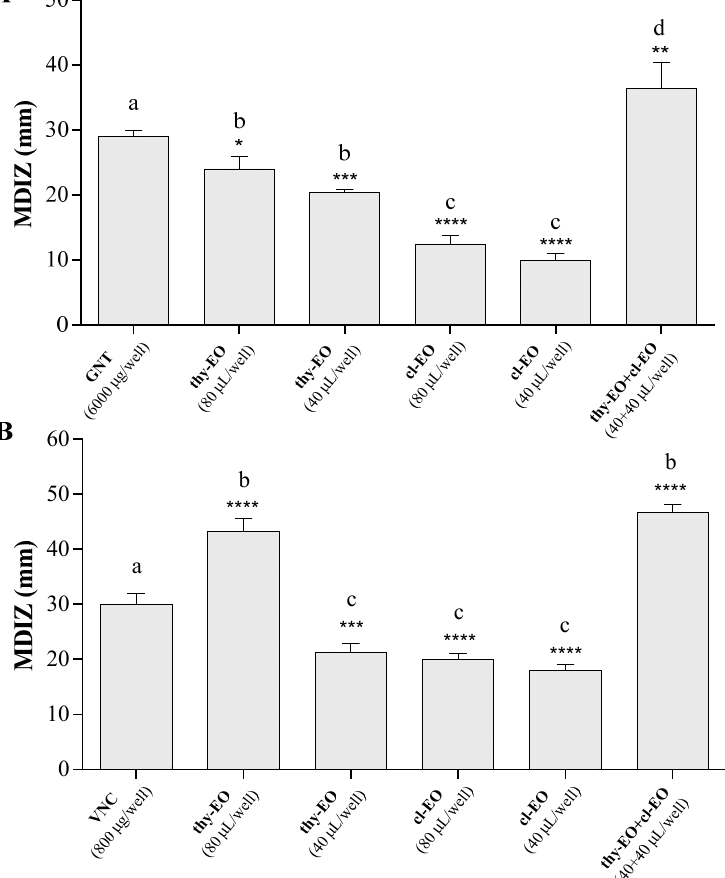
Figure 1. In vitro antibacterial activity of thyme and cloves essential oils, individually used and in binary combination (1:1 ratio), evaluated by the agar well diffusion method, against Escherichia coli ( A ) and Staphylococcus aureus ( B ) food isolates. Graphical representation of the results; the mean diameter of inhibition zone (in mm) is reported as the mean of values obtained from assays in triplicate ± standard deviation. Statistical significance was examined by the one-way ANOVA test, with Dunnett’s correction ( p < 0.05) for bars comparison with positive control bar, and with Tukey’s correction ( p < 0.05) for multiple comparisons between bars. Asterisks indicate the statistical significance respect to the positive control (**** p < 0.0001; *** p < 0.001; ** p < 0.01; * p < 0.05); the absence of asterisks indicates absence of significance. Letters (a, b, c, d) are used for multiple comparisons. Different letters indicate significant differences between bars; bars with no significant differences receive the same letter. MDIZ, mean diameter of the inhibition zone; thy-EO, thyme essential oil; cl-EO, cloves essential oil; GNT, gentamicin; VNC, vancomycin. Quantitative assays confirmed the in vitro antibacterial activity of the EOs. Table 2 reports the values of minimum inhibitory concentration (MIC) and minimum bactericidal concentration (MBC). Thyme and cloves essential oils showed bacteriostatic and bactericidal effects against E. coli mC1 and S. aureus mC2 isolates. The inhibitory activity of EOs on food pathogens is appreciable both when they were used individually and in binary